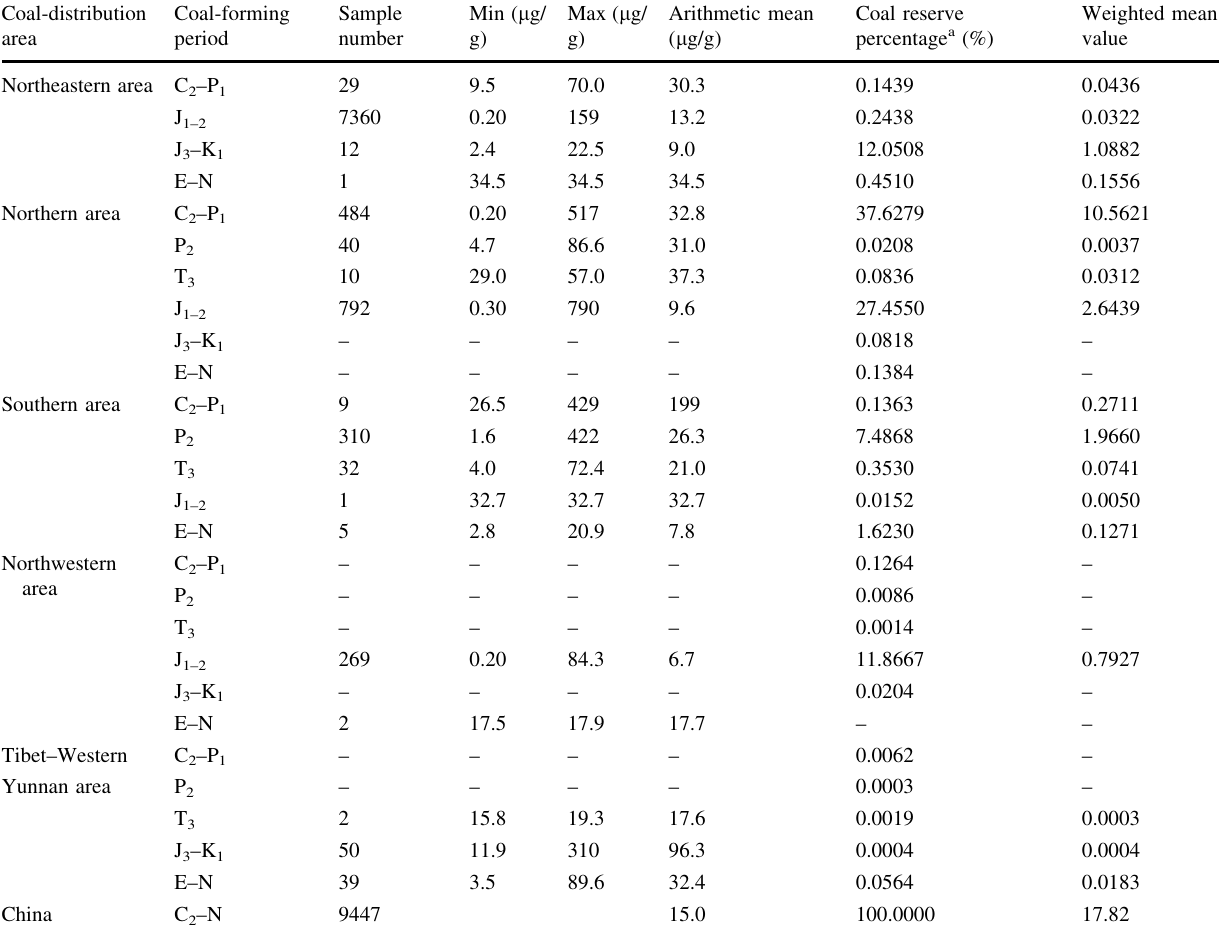
Table 4 Contents of lead in Chinese coals by